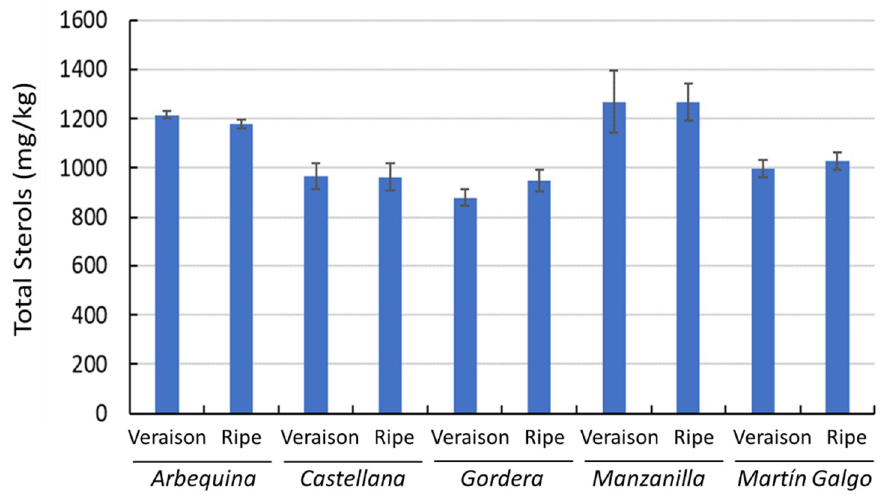
Figure 3. Total sterol content (mg/kg) the monovarietal oils produced with the varieties of olives grown in the Aceite de la Alcarria PDO (veraison and ripe). Mean values for the samples collected across the four consecutive olive crop seasons under study. No significant differences were found between maturation stages (Duncan test, p < 0.05).